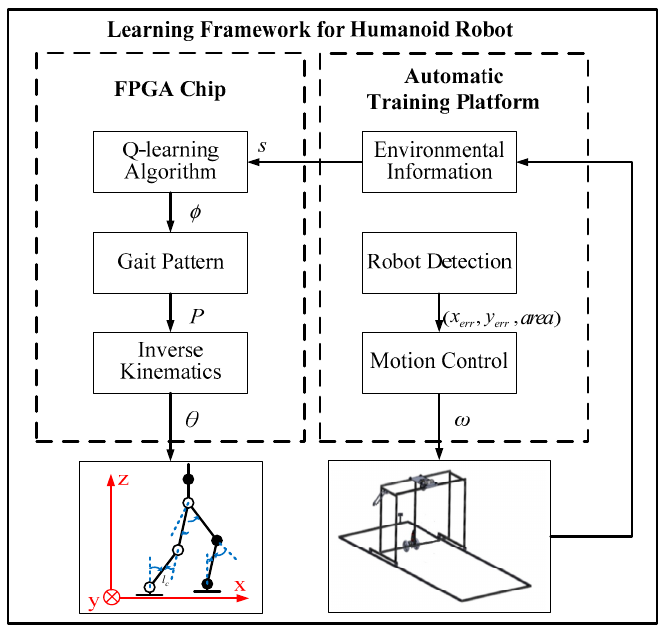
Figure 7. System architecture of the proposed learning framework.